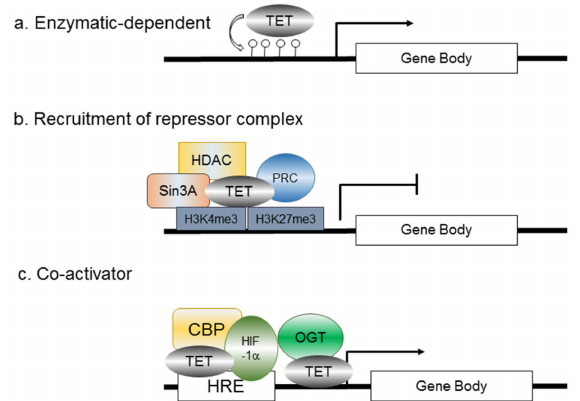
Figure 5. Mechanisms of TET-mediated transcription. ( a ) The canonical regulation of TET-mediated transcription relies on its dioxygenase activity, which turns 5mC into 5hmC; ( b ) A subset of TET proteins can recruit repressor complexes, such as PRC and Sin3A/HDAC, whereas a great proportion of TET proteins are found to bind to the CpG islands of TSS. As in the case of ES cells, TET enacts the dual functions by facilitating transcription of pluripotency factors via DNA demethylation and transcriptionally repressing developmental regulators; ( c ) TET proteins also act as a co-activator under hypoxia. TET proteins are associated with HIF-1 α and CBP proteins at the HRE of a set of metabolic genes, e.g., INSIG1 . TET can also interact with OGT at TSS. This leads to histone 2B Ser112 GlcNAc, and it further facilitates its monoubiquitination [91], presumably activating transcription. PRC: Polycomb repressive complex; HDAC: histone deacetylase; HRE: hypoxia-response element; OGT: O-GlcNAc